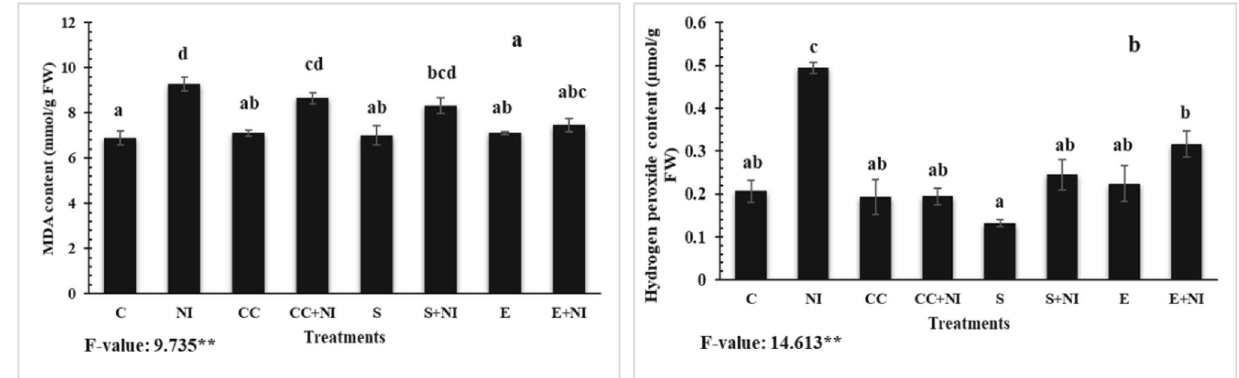
Figure 4. ( a-b ) Level of stress markers ( a ) MDA content; ( b ) H 2 O 2 content in M. incognita inoculated 60 days old tomato plants treated with bioactive components produced by S. hydrogenans strain DH-16. Different treatments are represented as C (control), NI (nematode inoculated), CC (culture cells), CC + NI (culture cells + nematode inoculated), S (supernatant), S + NI (supernatant + nematode inoculated), E (crude extract), E + NI (crude extract + nematode inoculated). Results are given in mean ± standard error form and F-value ** indicates significance at p ≤ 0.01 as per Tukey’s test. Different letters a, b, c, d represent significant difference among treatments and same letters represent no significant difference.